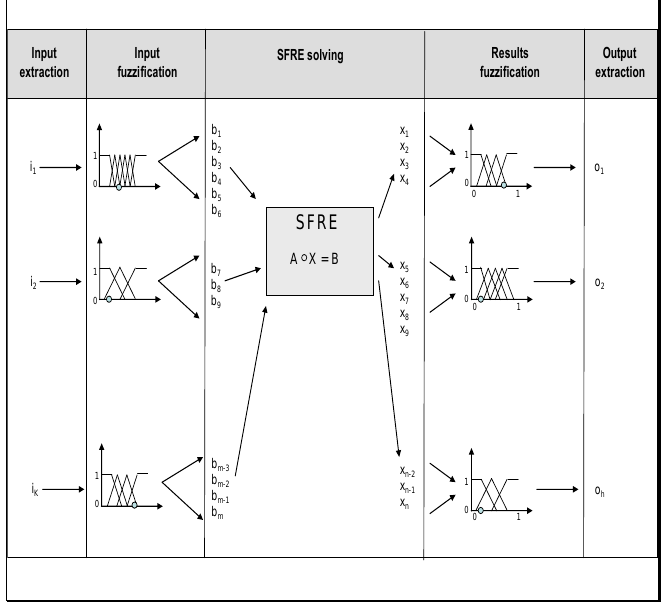
Fig. 1. Resolution process of a